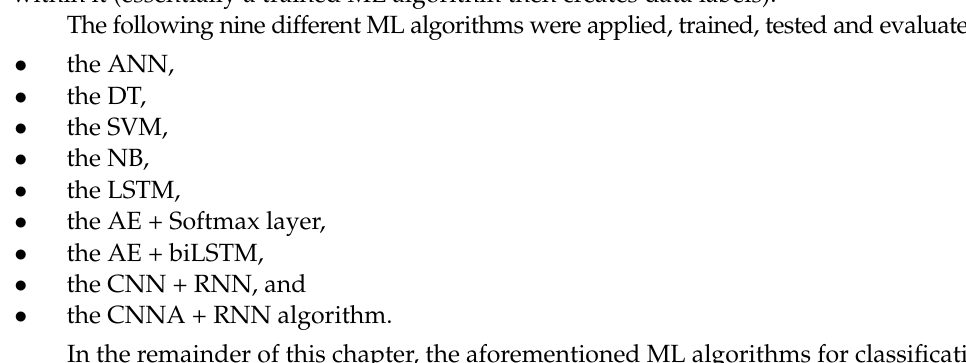
Figure 7. Auto encoder